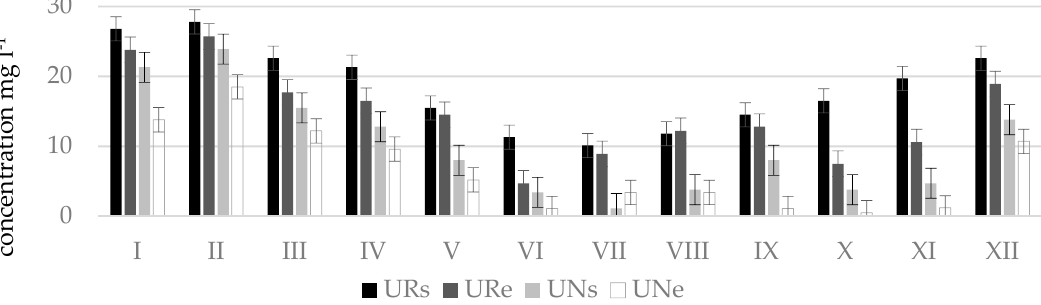
Figure 4. Nitrate concentrations ( NO (cid:2871)(cid:2879) ) in natural (N) and regulated (R) stretches of Uogis stream.